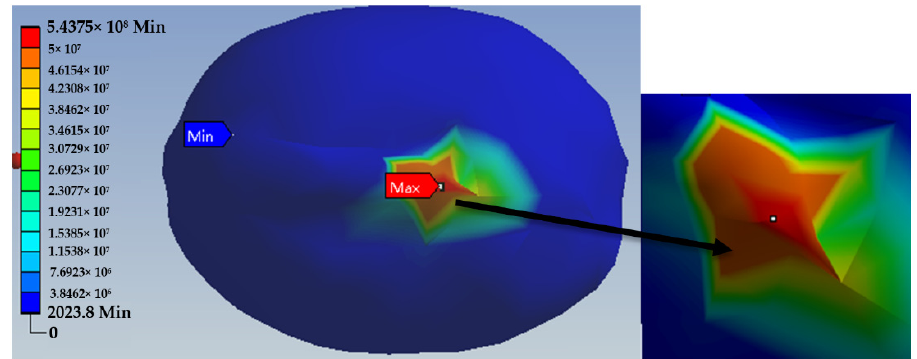
Figure 12. Stress cloud map of the walnut under unidirectional load.